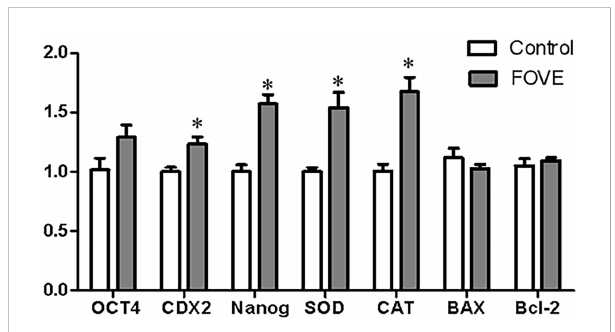
FIGURE 4 Relative levels of gene expression in blastocysts. Values are shown as mean ± SD. *Signi fi cant difference compared with the control group ( P <